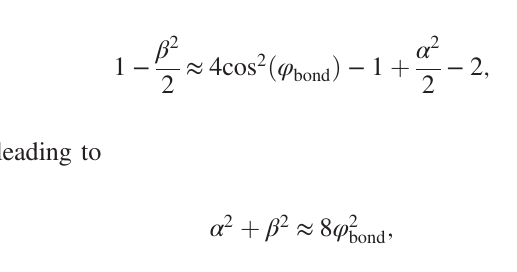
ffiffiffi p ffiffiffi p 8 φ =l ¼ 2 k is reproduced. Remember that bond scat ¼ l scat trans